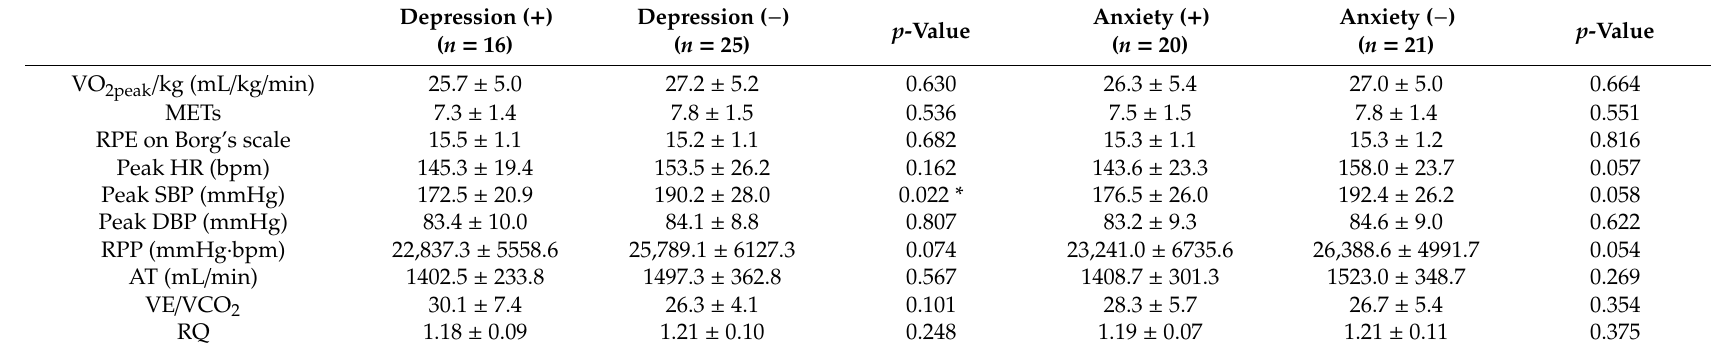
Table 3. Associations between the results of symptom-limited exercise tolerance test and depressive and anxious symptoms. Depression ( + ) ( n =